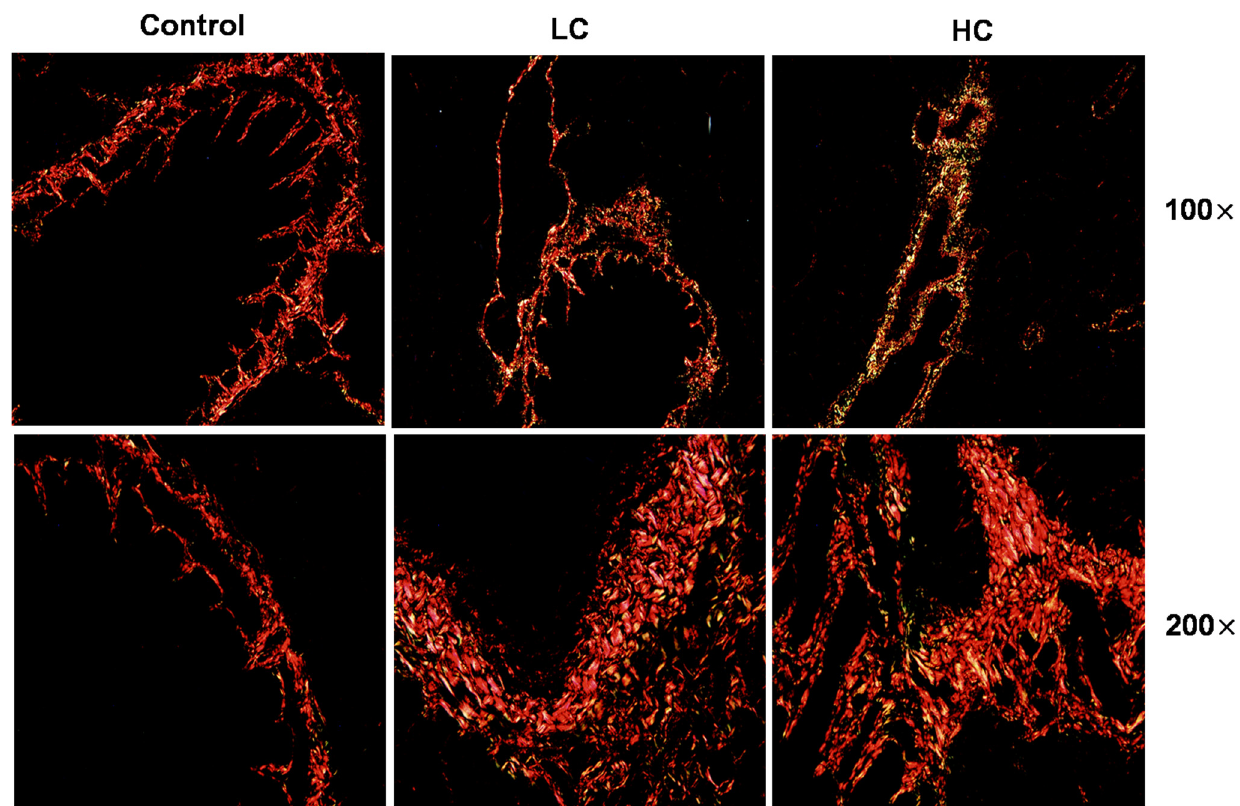
Figure 1. OMPM-induced PF in Wistar rat lung tissues with Sirius Red staining; 100×, bar: 100 μ m; 200×, Bar: 50 μ m.